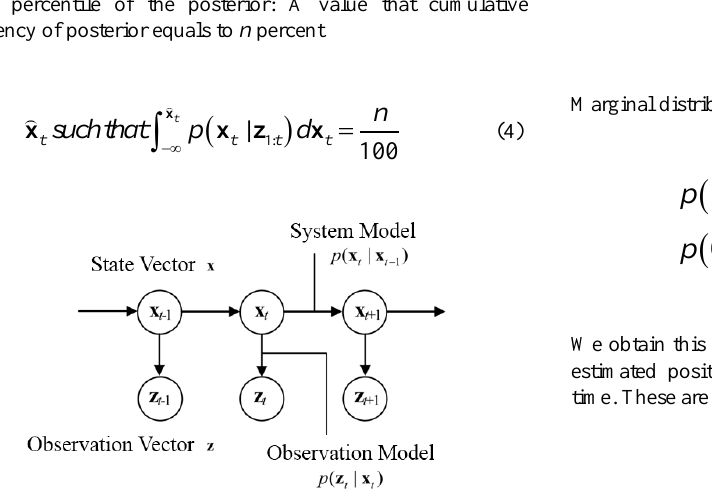
Figure 1. General state space